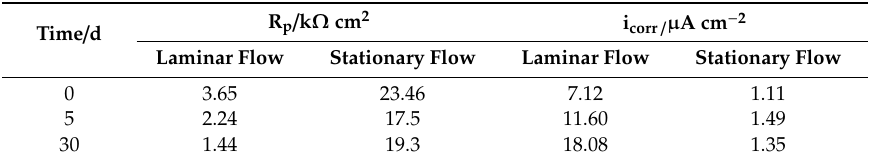
Table 5. Polarisation resistance ( R p ) and corrosion current density values for AA6061-T6 immersed up to 30 days in Caribbean seawater with laminar and stationary flows.